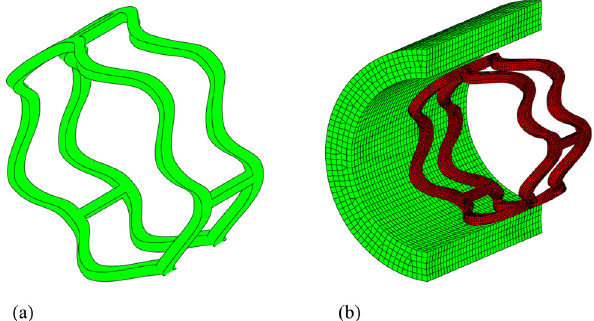
Figure 1: ( a ) Representative segment of PLLA stent. ( b ) Finite ele - ment model of PLLA stent segment in an